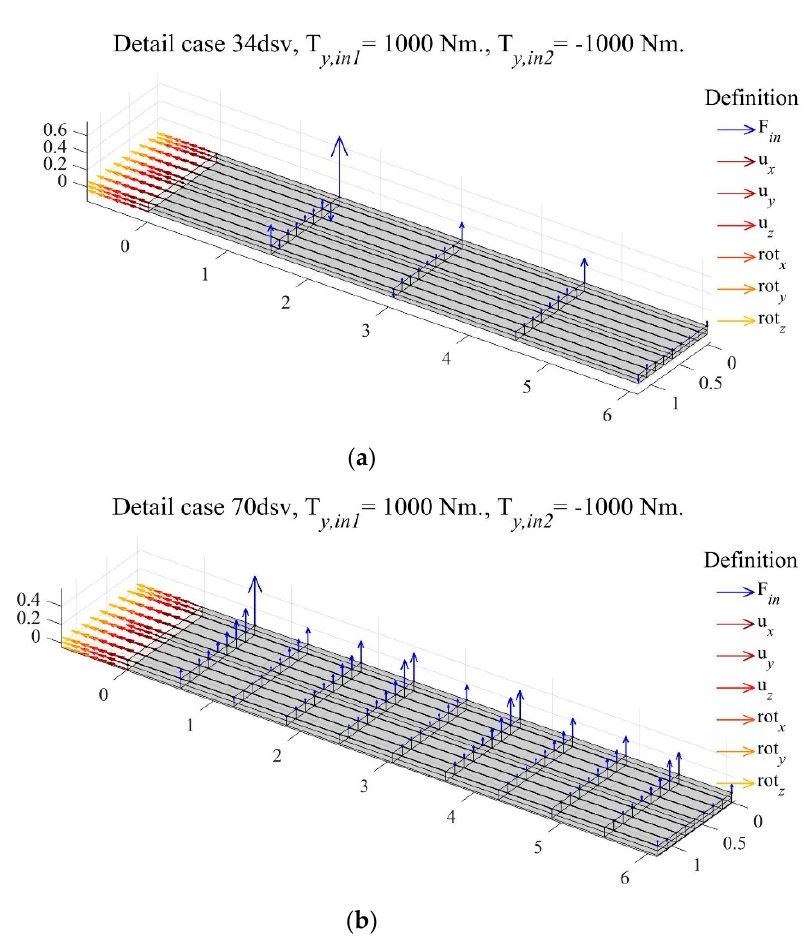
Figure 6. Boundary condition set for the wing structure simulation in ( a ) Case. I. and ( b ) Case. II.